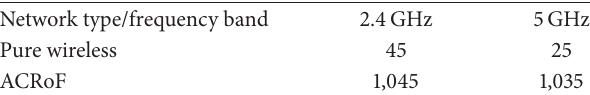
Table 2: System reach in